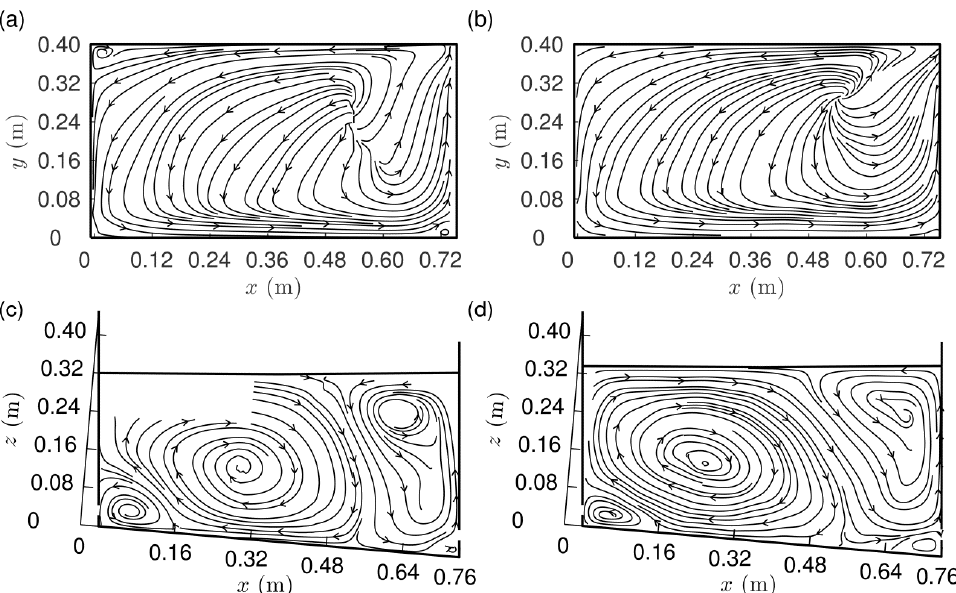
Figure 4. Streamlines of time-averaged velocities (left: PIV; right: mesh A model ): ( a , b ) plane 2 ( z = 0.088 m); ( c , d ) plane 5 ( y = 0.20 m).